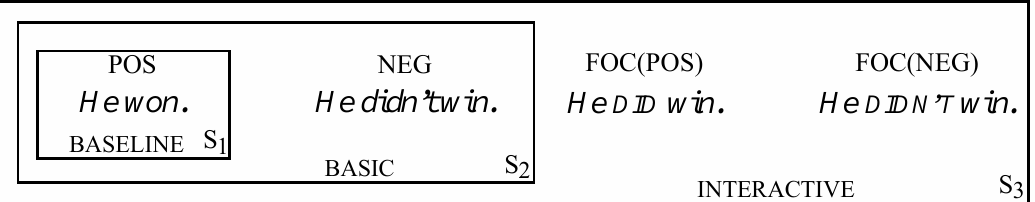
Figure 9. Polarity organized in strata.